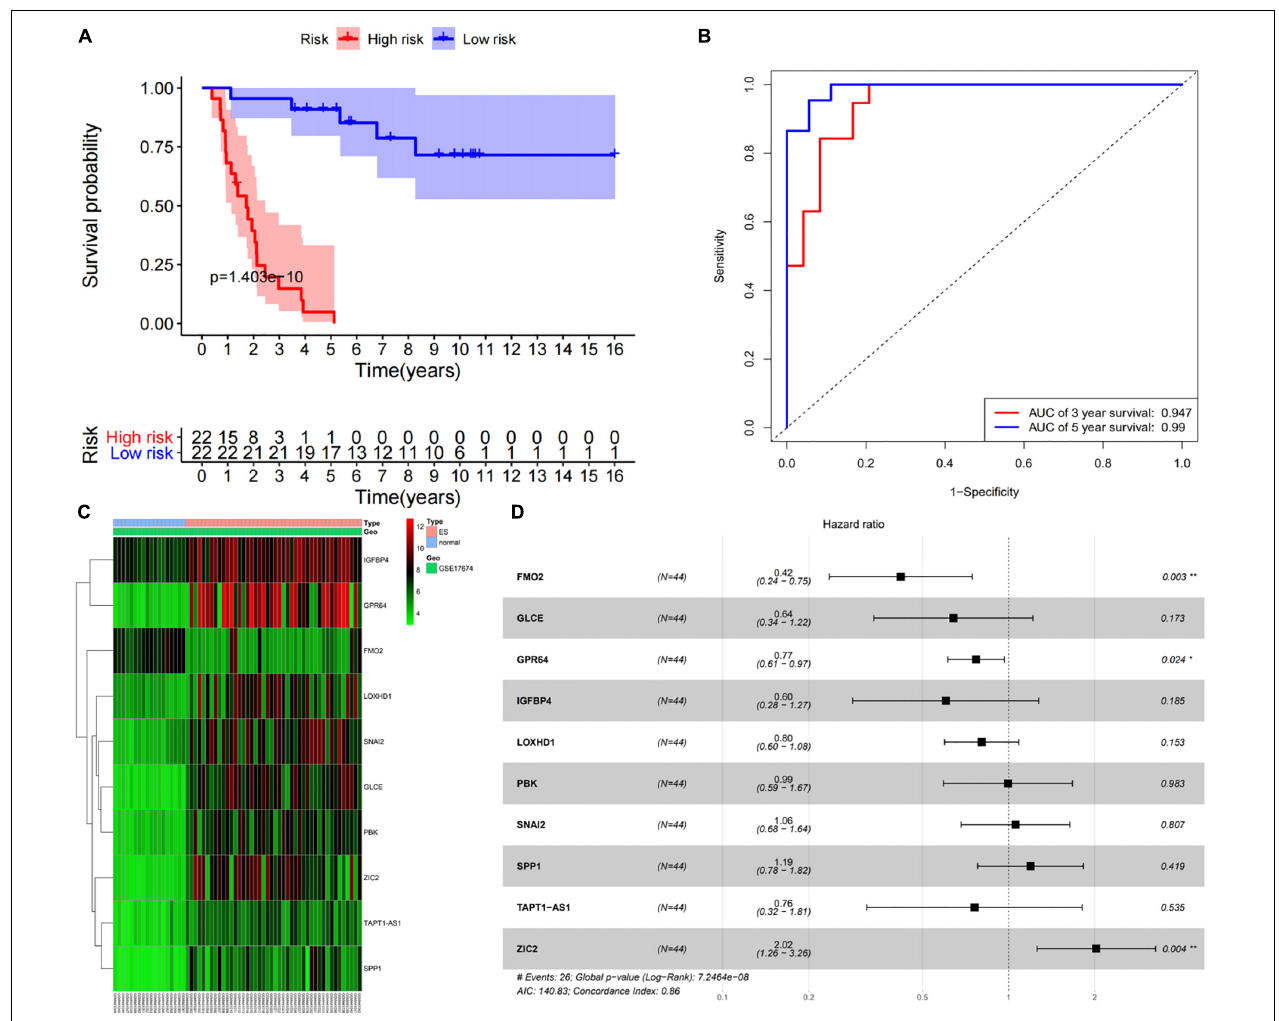
FIGURE 6 | Prognostic value of 10 immune-related gene signatures. (A) The survival curve show that low risk level has better prognosis in training set (GES17674). (B) The ROC curve for 3-and 5-overall survival of ES patients in training set (GES17674). (C) Heatmap showed the expression level of 10 genes in the normal group and ES group. (D) The results of multivariate Cox regression of 10